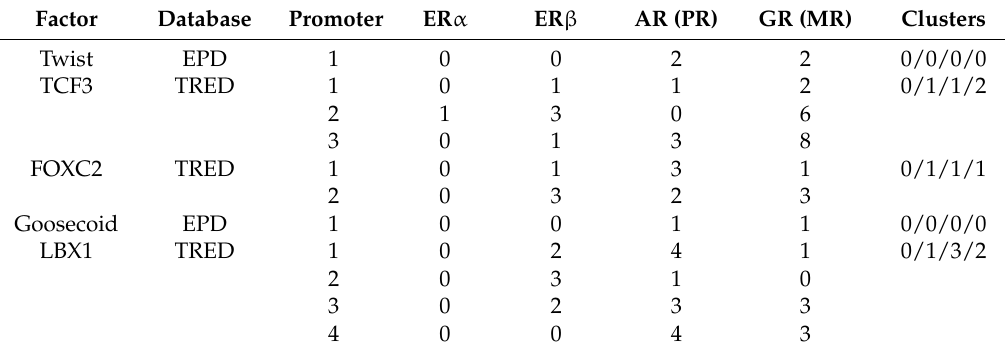
Table 2. Number of binding sites of SNRs in the different promoters of Epithelial-Mesenchymal Transition (EMT) core transcription factors Twist, TCF3, FOXC2, Goosecoid and LBX1, listed in the TRED and EPD databases. PR and MR appear in parentheses in the AR and GR column headings, respectively, as they have the same binding sites. In the last column, the number of promoters with clusters (more than three binding sites) for each SNR is